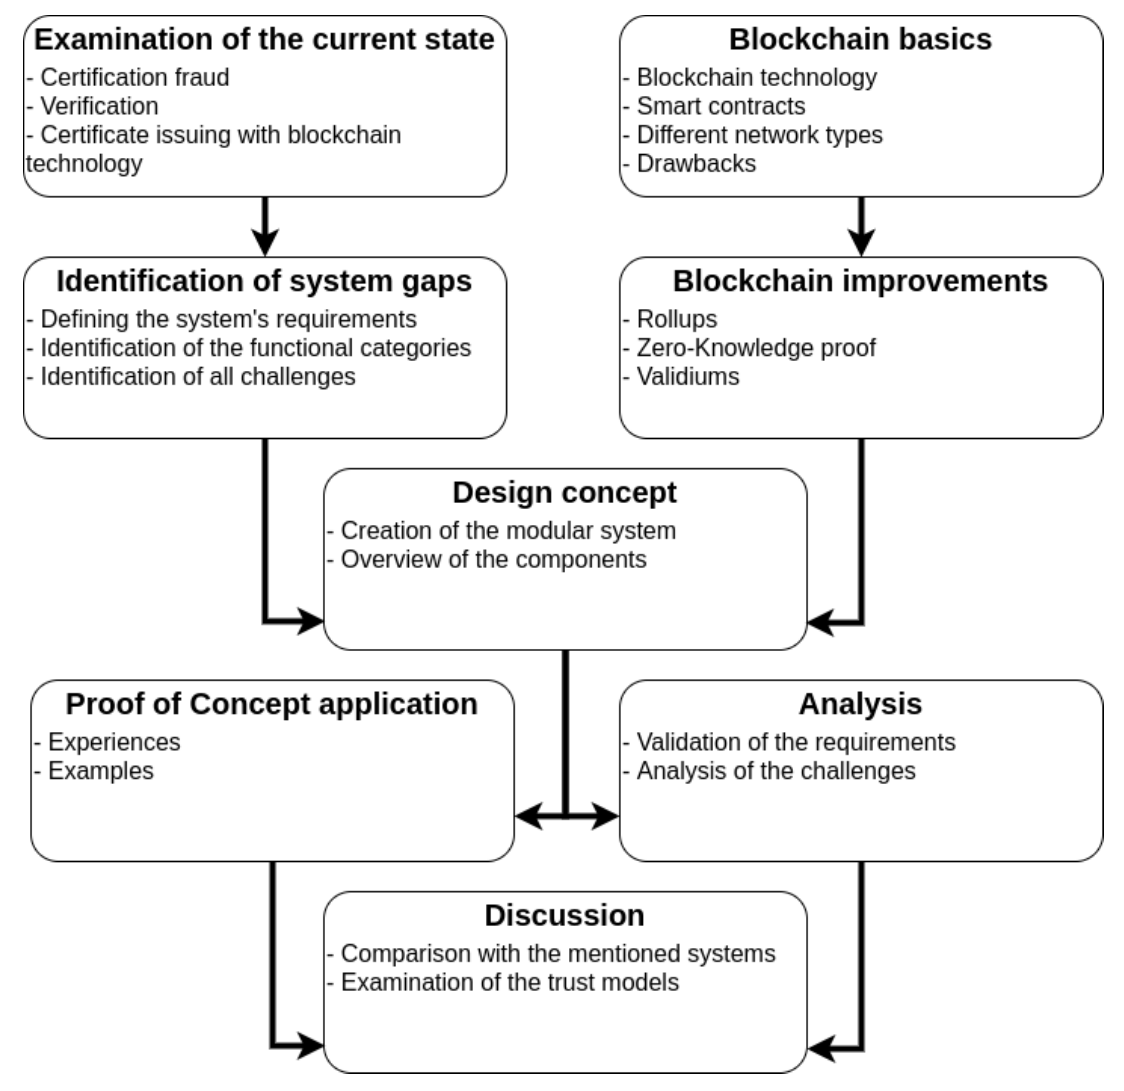
Figure 1. The structure of the